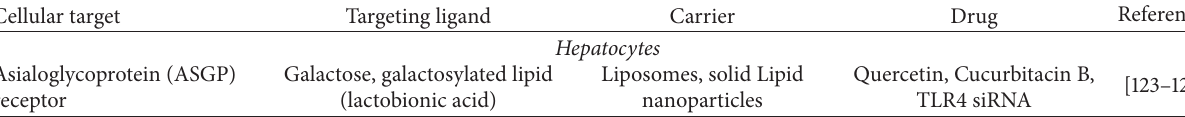
Table 2: Targeting strategies explored for the preclinical therapeutic treatment of liver